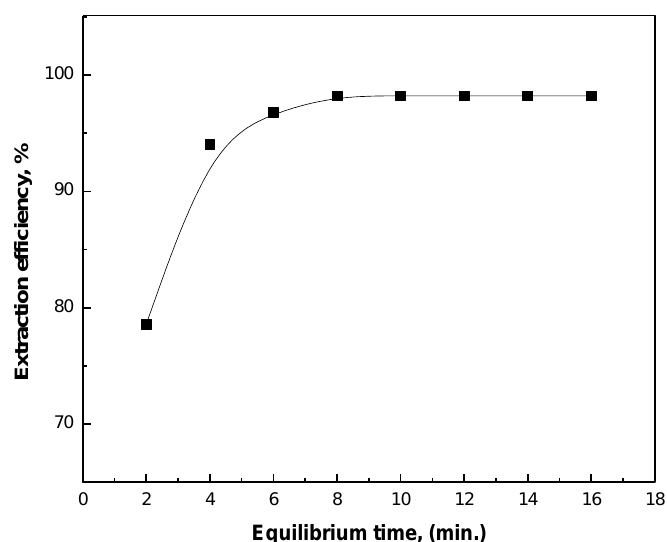
Fig. 7. Effect of equilibrium time on the extraction of copper. Conditions: pH 5.5, O/A = 1, Na 2 SO 4 = 0.5 mol L -1 , 15% (v/v) furfuryl thioalcohol in